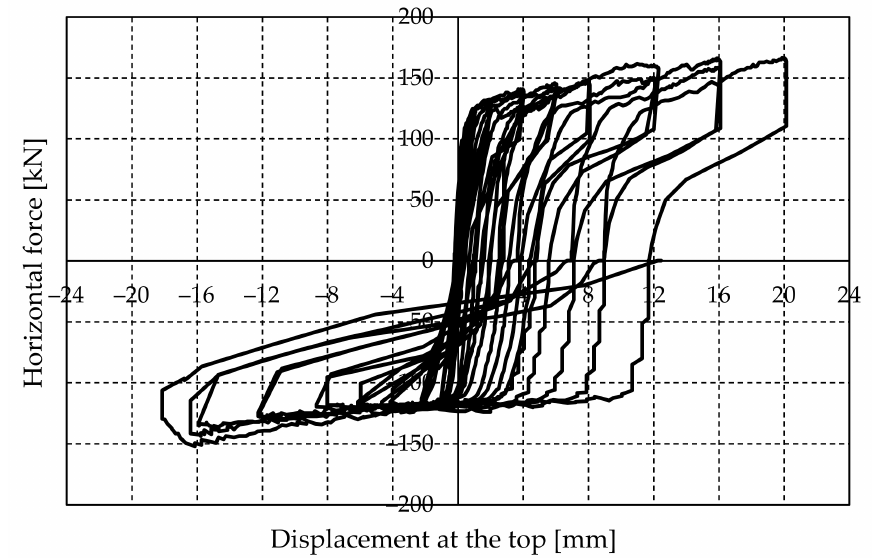
Figure 17. Force—displacement diagram for W3 (V = 230 kN, σ v = 0.4 N/mm 2 ).